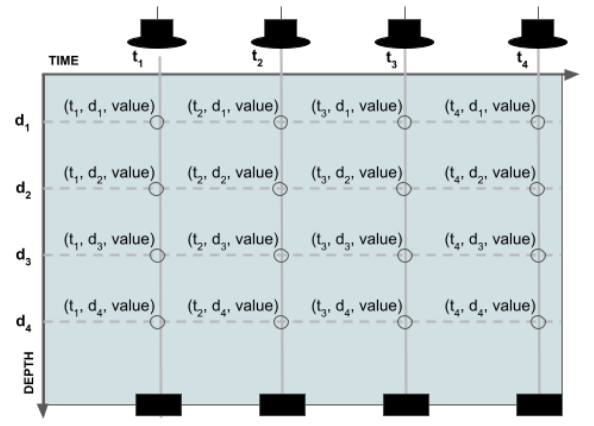
Figure 5. Schema of the profile type data composed by timestamp (t n ), depth (d n ) and value.